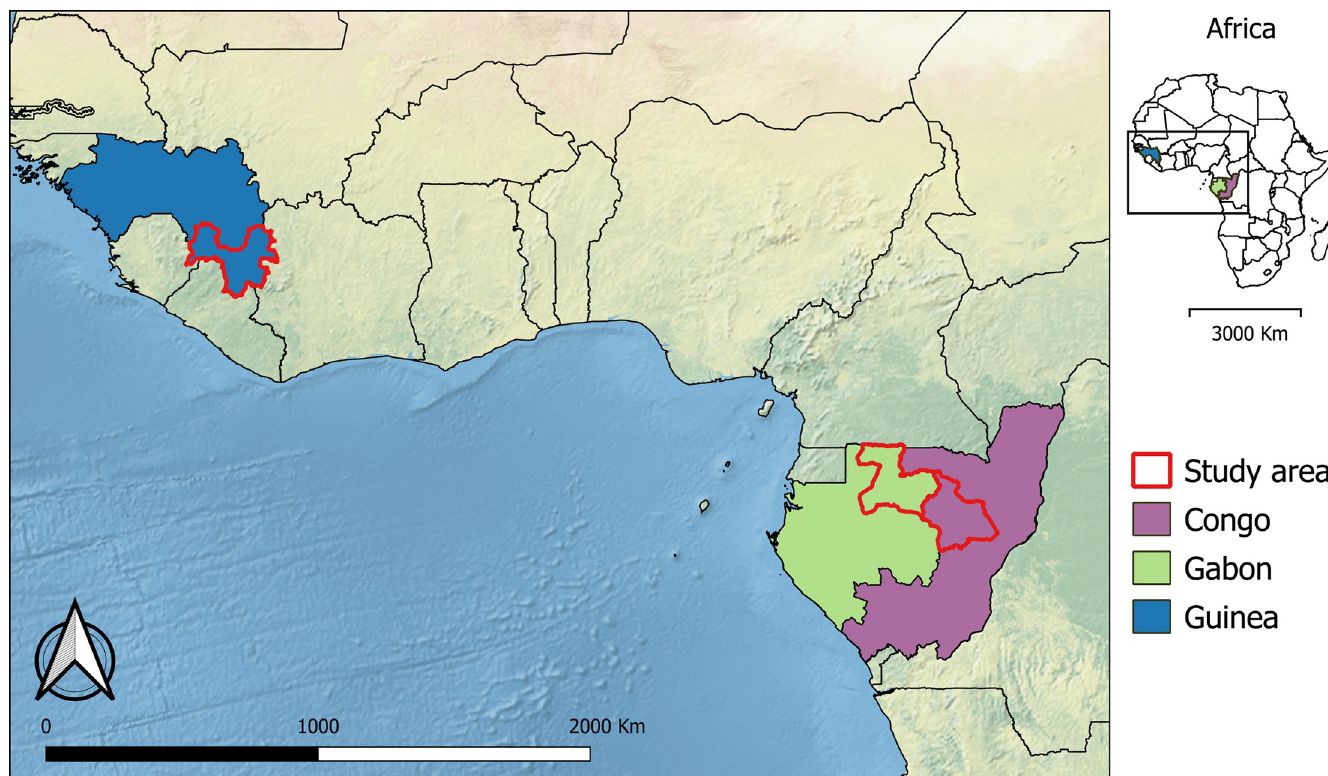
Fig 1. Study areas in Guinea, Congo and Gabon. Background: Natural Earth / with Shaded Relief and Water (https://www.naturalearthdata.com).